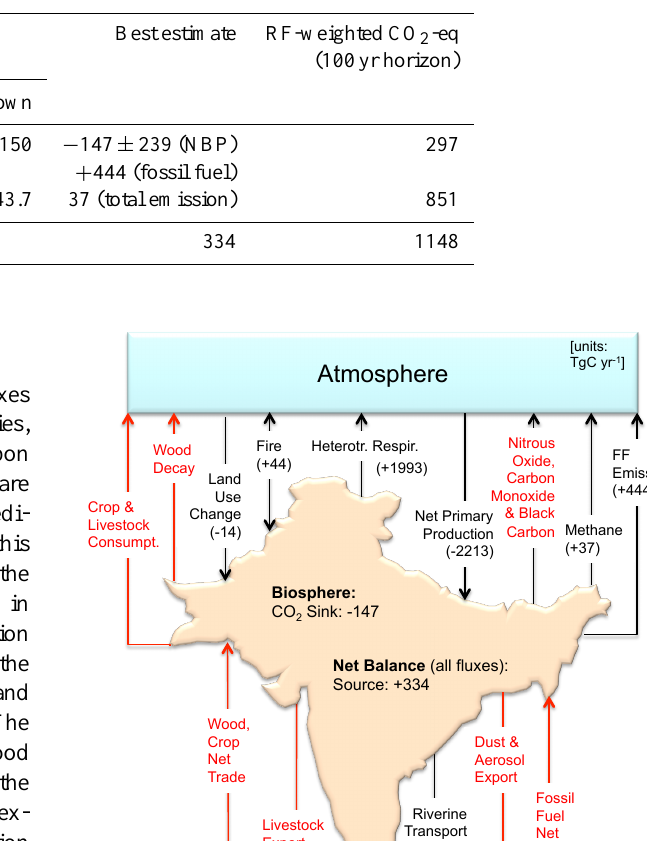
Table 6. Annual fluxes of CO 2 and CH 4 (TgCyr − 1 ). The best-estimate net flux is computed using the mean of top-down and bottom-up estimates.